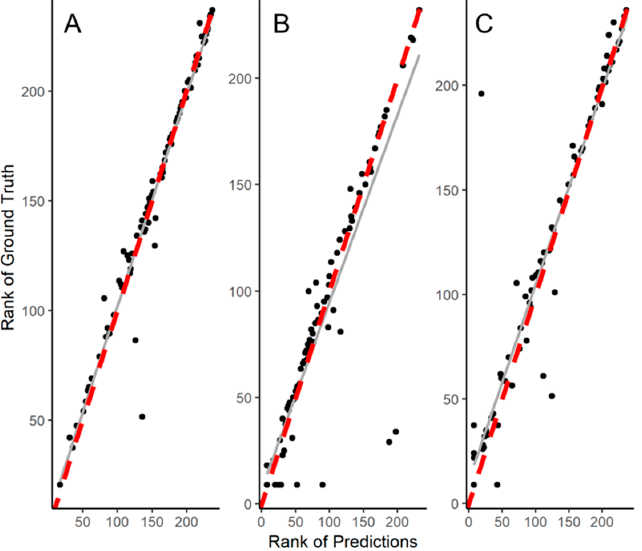
Figure 5. Correlation. Linear regression plots for the differences and agreement between deep learning predicted Agatston scores and the ground truth manually annotated scores for ( A ) total cardiac calcium, ( B ) coronary artery calcium, and ( C ) aortic calcium.